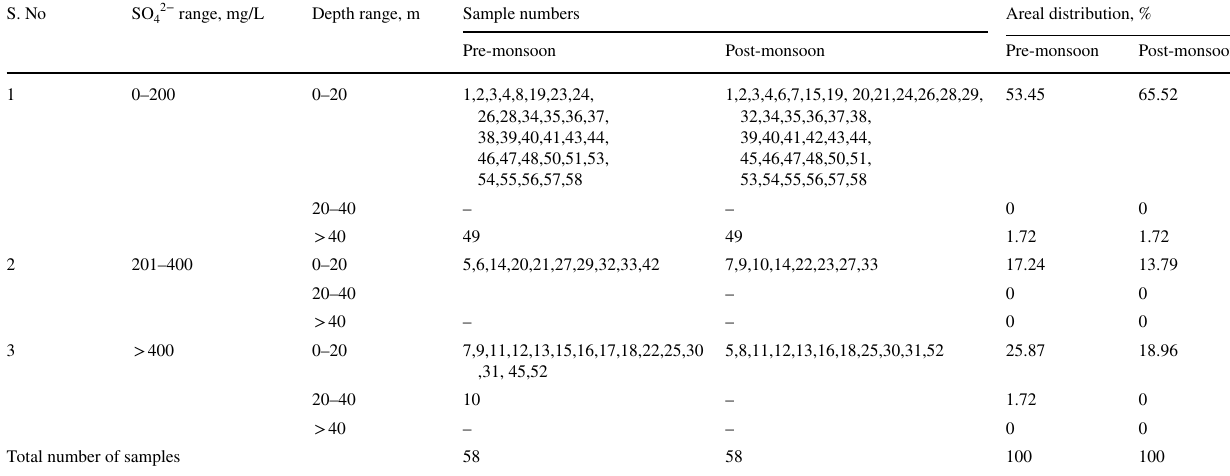
Table 7 SO 42− distribution in groundwater of the study area S. No SO 42− range,